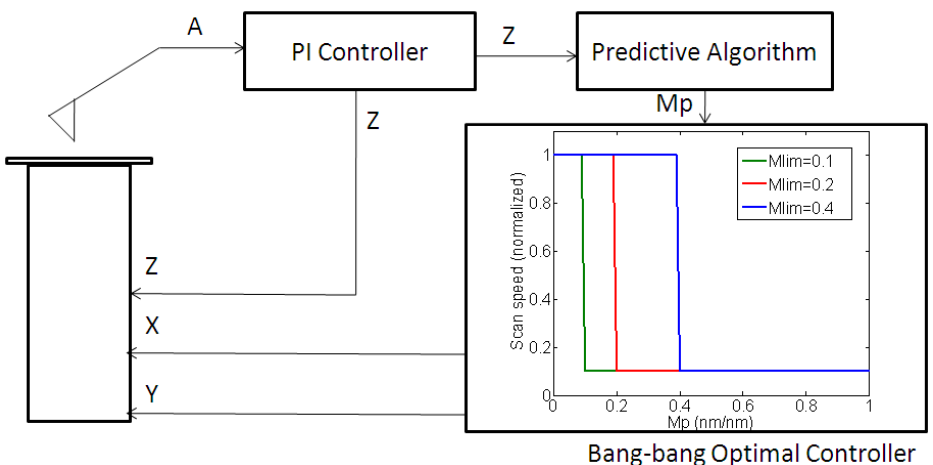
is the predicted p